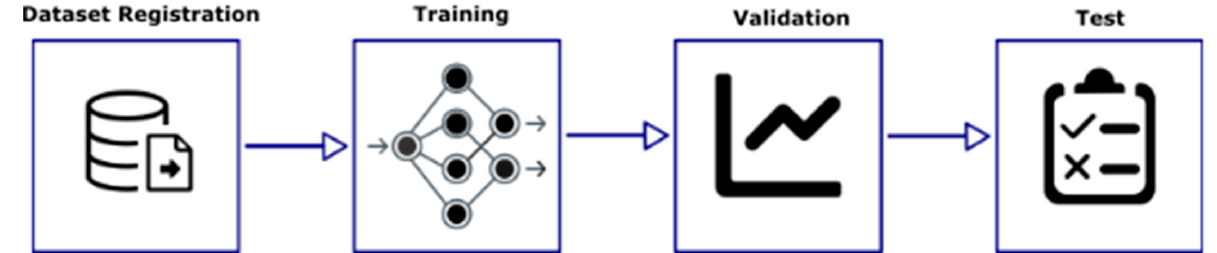
Figure 8. Training, validation, and test.